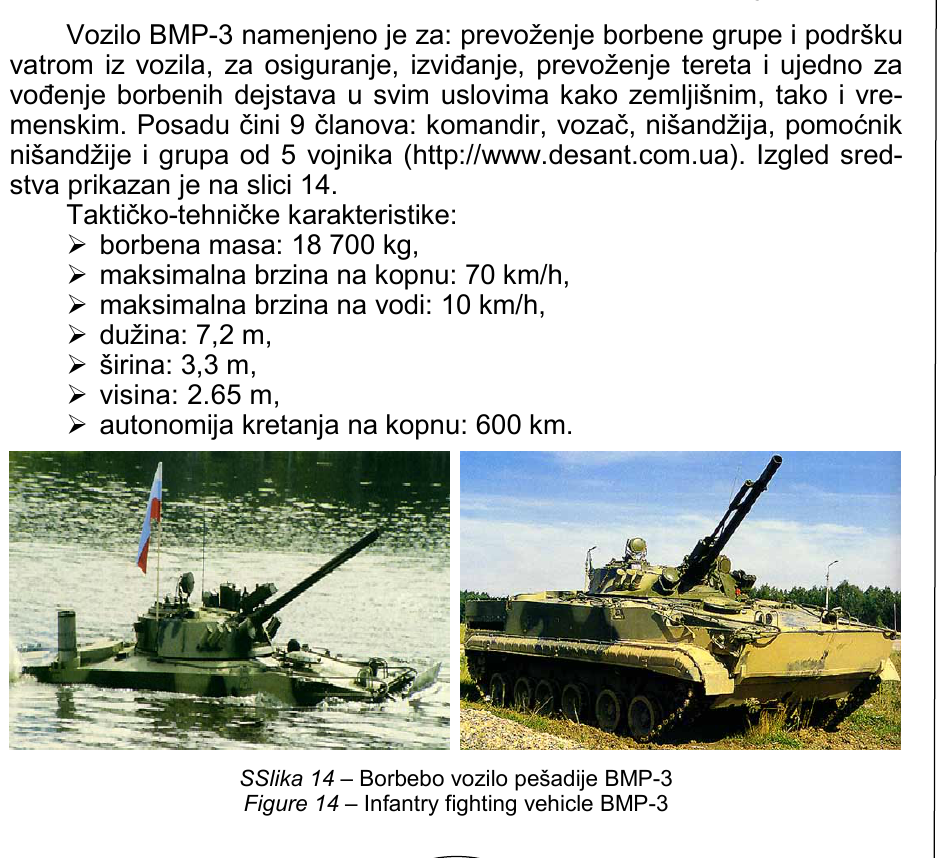
Figure 13 – Desant fighting vehicle BMD-2 Borbeno vozilo pešadije